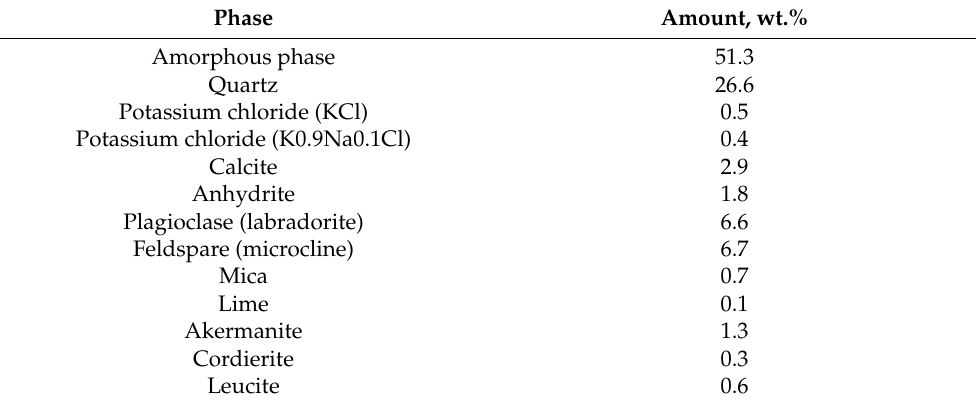
Table 3. Phase composition of Fly Ash from biomass combustion (FAB).